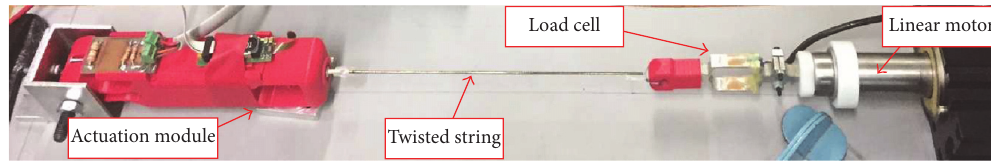
Figure 6: Overview of the experimental setup for validation of the actuation module.